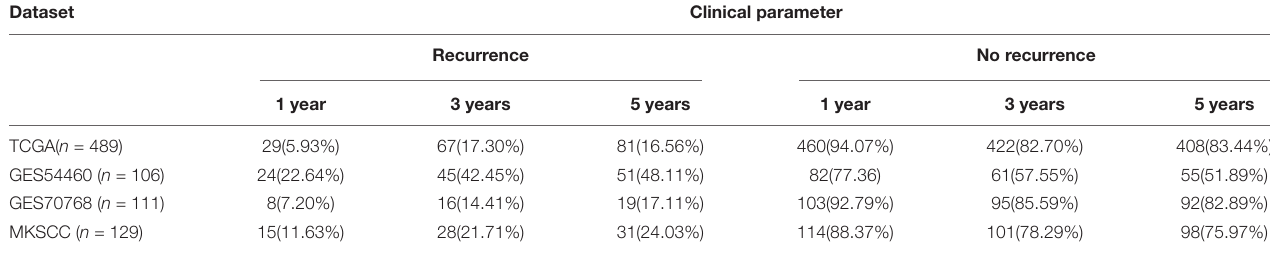
TABLE 4 | Clinical recurrence rate in TCGA, GES54460, GES70768, and MKSCC database.